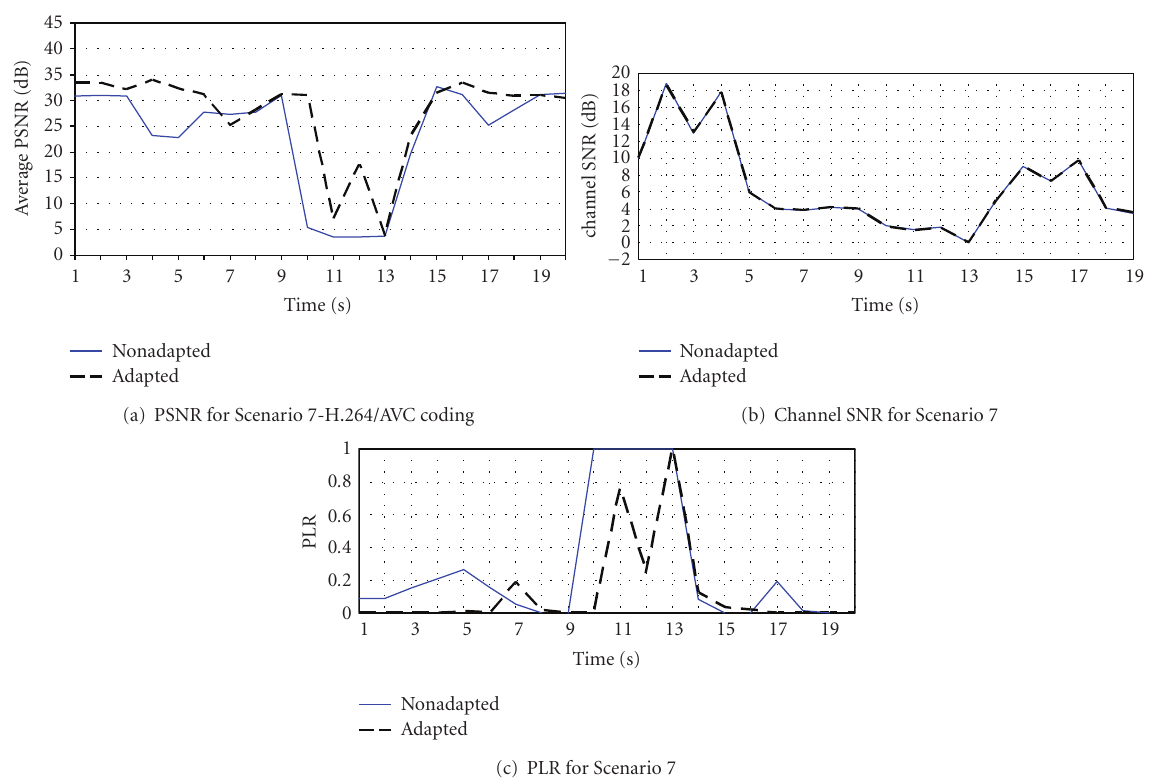
Figure 5: Simulation results with scenario 7 [16], video sequence duration 20 seconds: average PSNR (a), radio channel SNR (b) and packet loss ratio